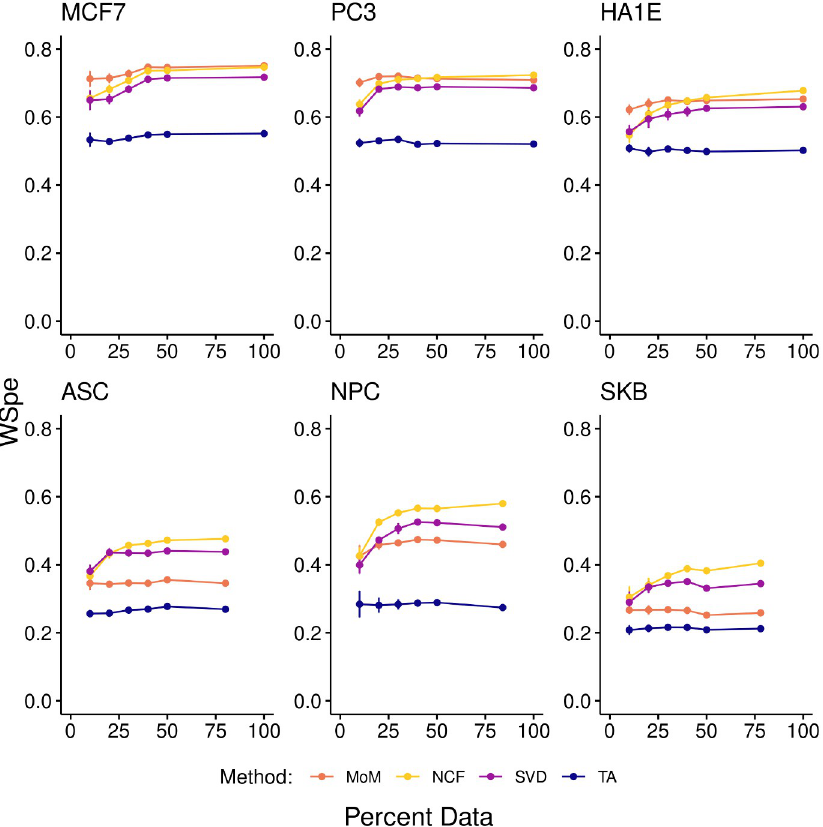
Fig 4. Downsampling. Negative WSpe for the named cells across all genes and drugs (y-axis), as a function of the percentage of the 1330 compounds whose data was available for imputation. Maximum x-values on each plot reflect the actual amount of data for that cell; all other points reflect downsampling. Error bars show the variation across cross-validation runs; most are smaller than the data markers.